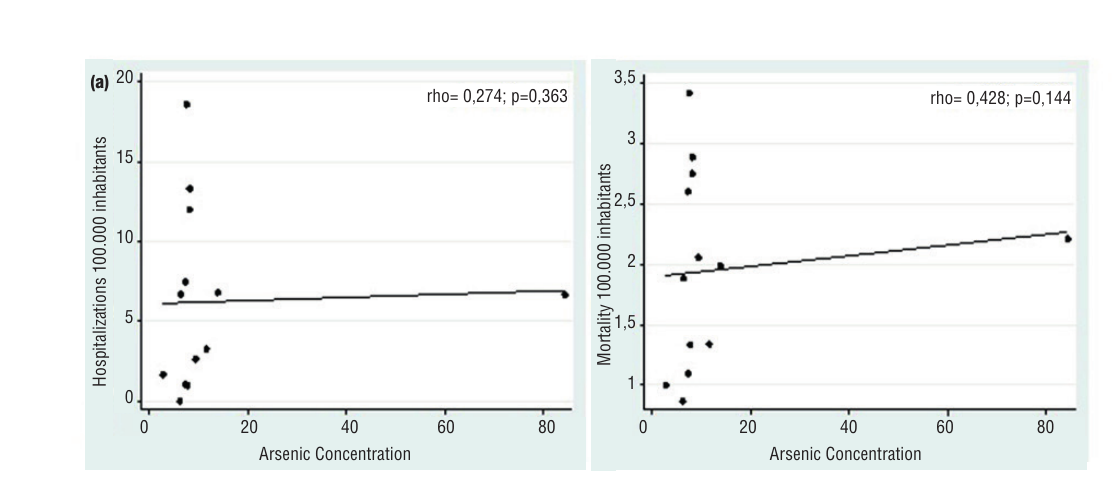
figure 2 - Association between arsenic contamination and hospitalization (a) and mortality (b) for bladder cancer in the state of Minas Gerais.